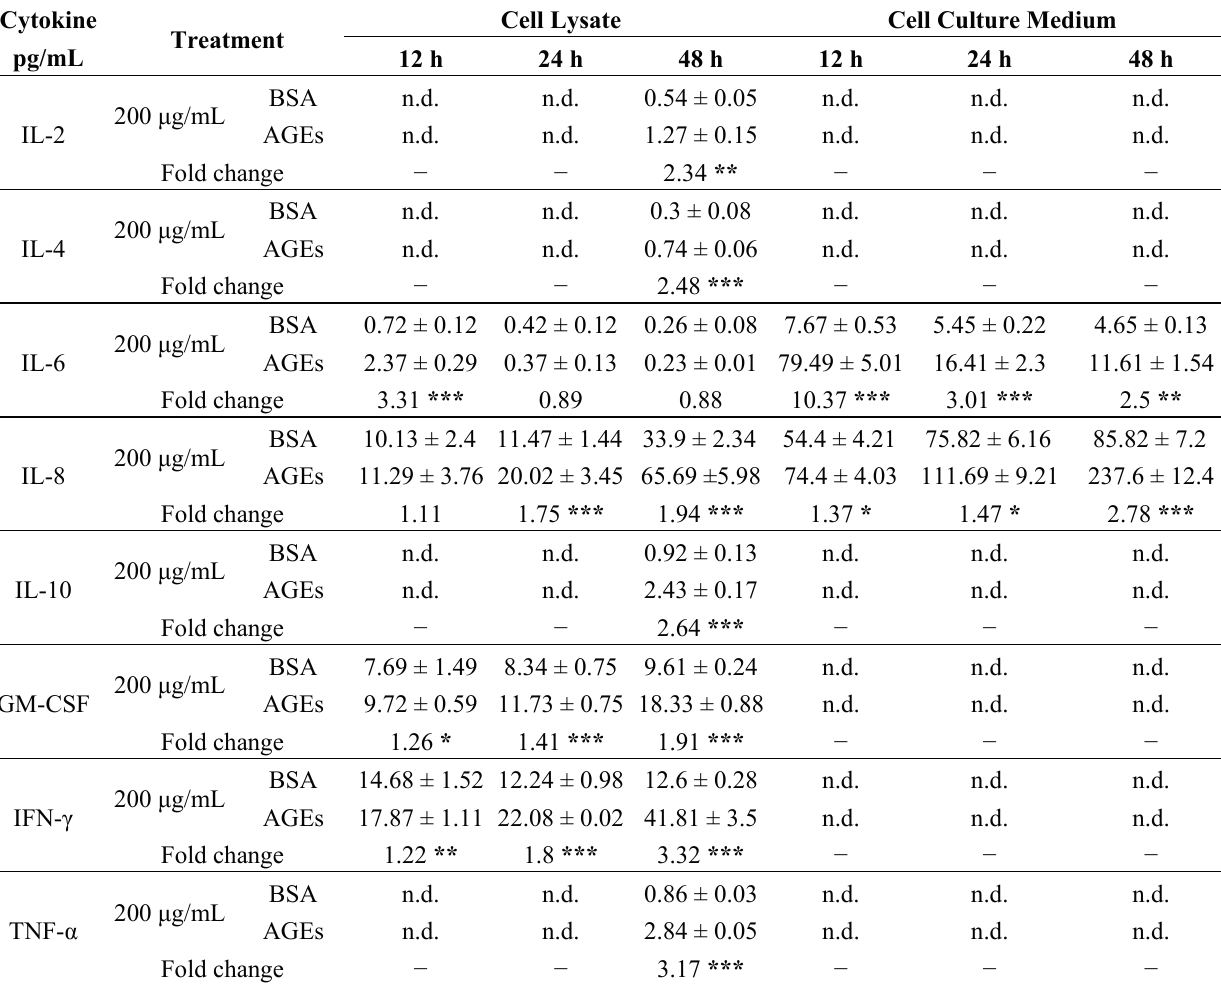
Table 1. Cytokine levels in HEK 293 lysate and in culture medium after exposure to AGEs or unglycated